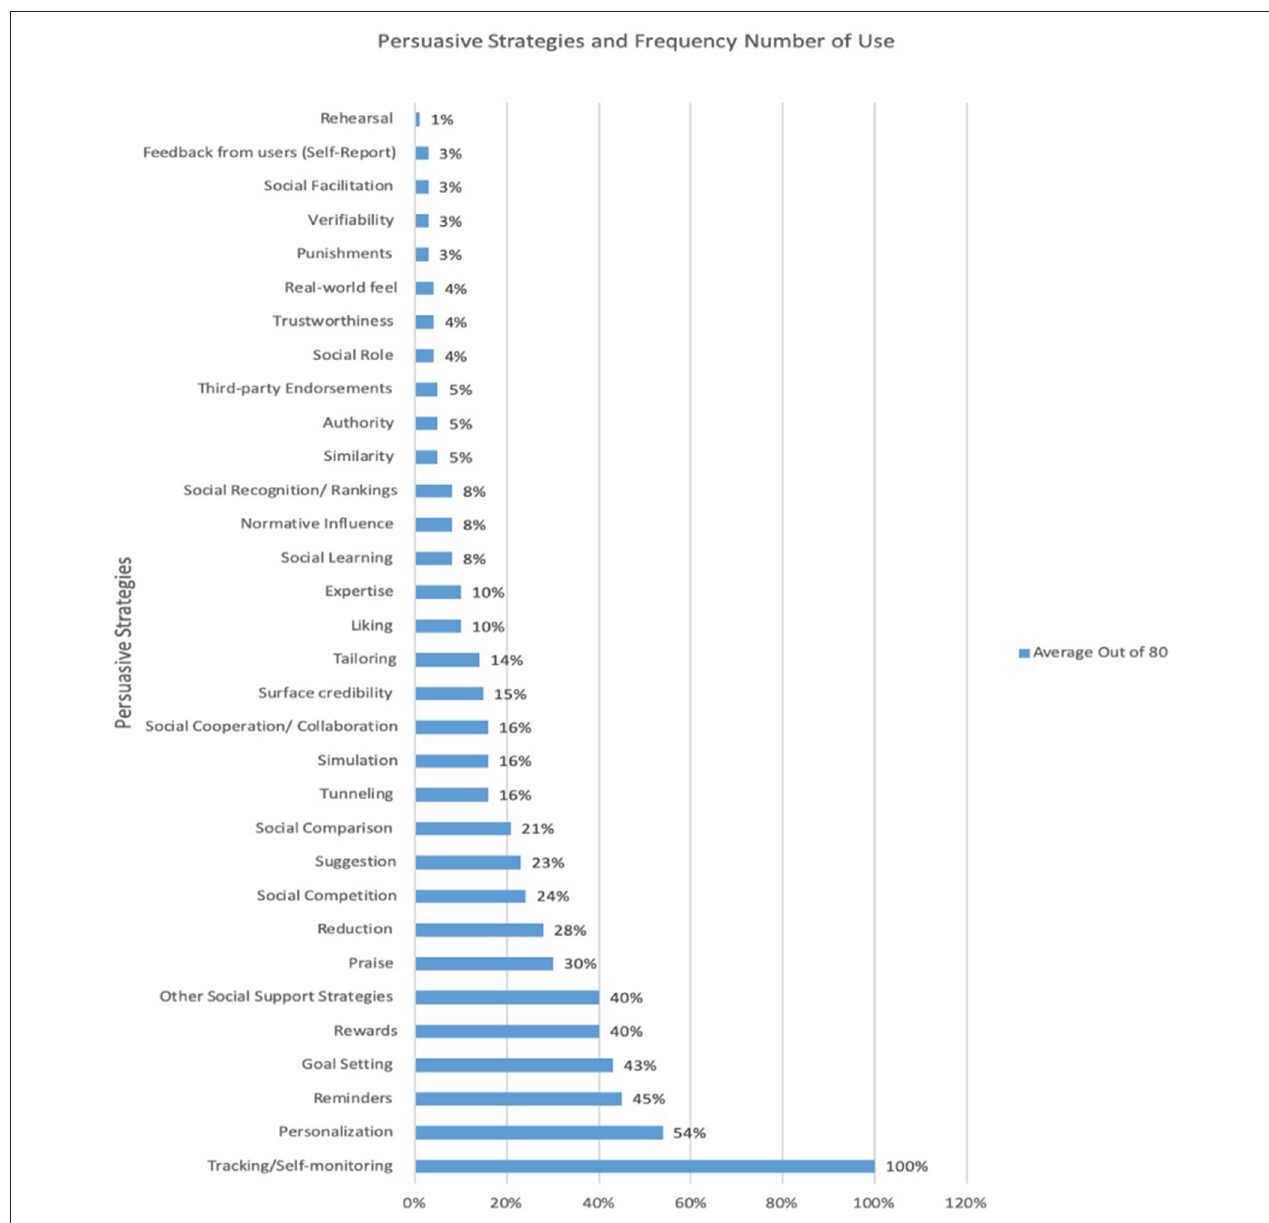
FIGURE 7 | Persuasive strategies and frequency of